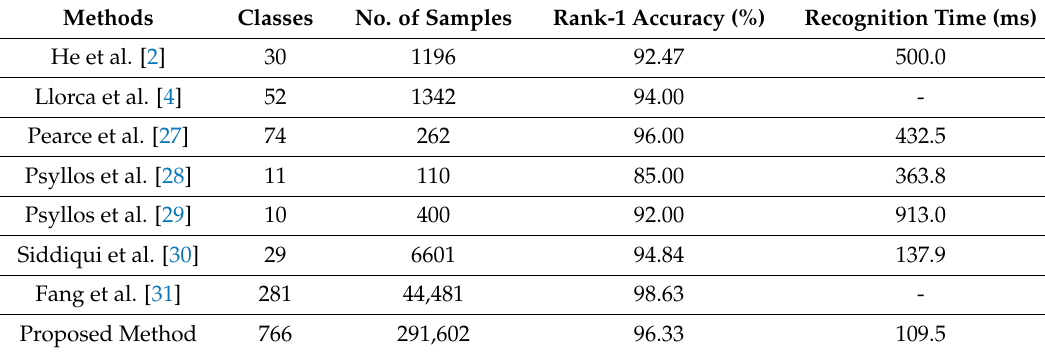
Table 5. Reported results of few state-of-the-art